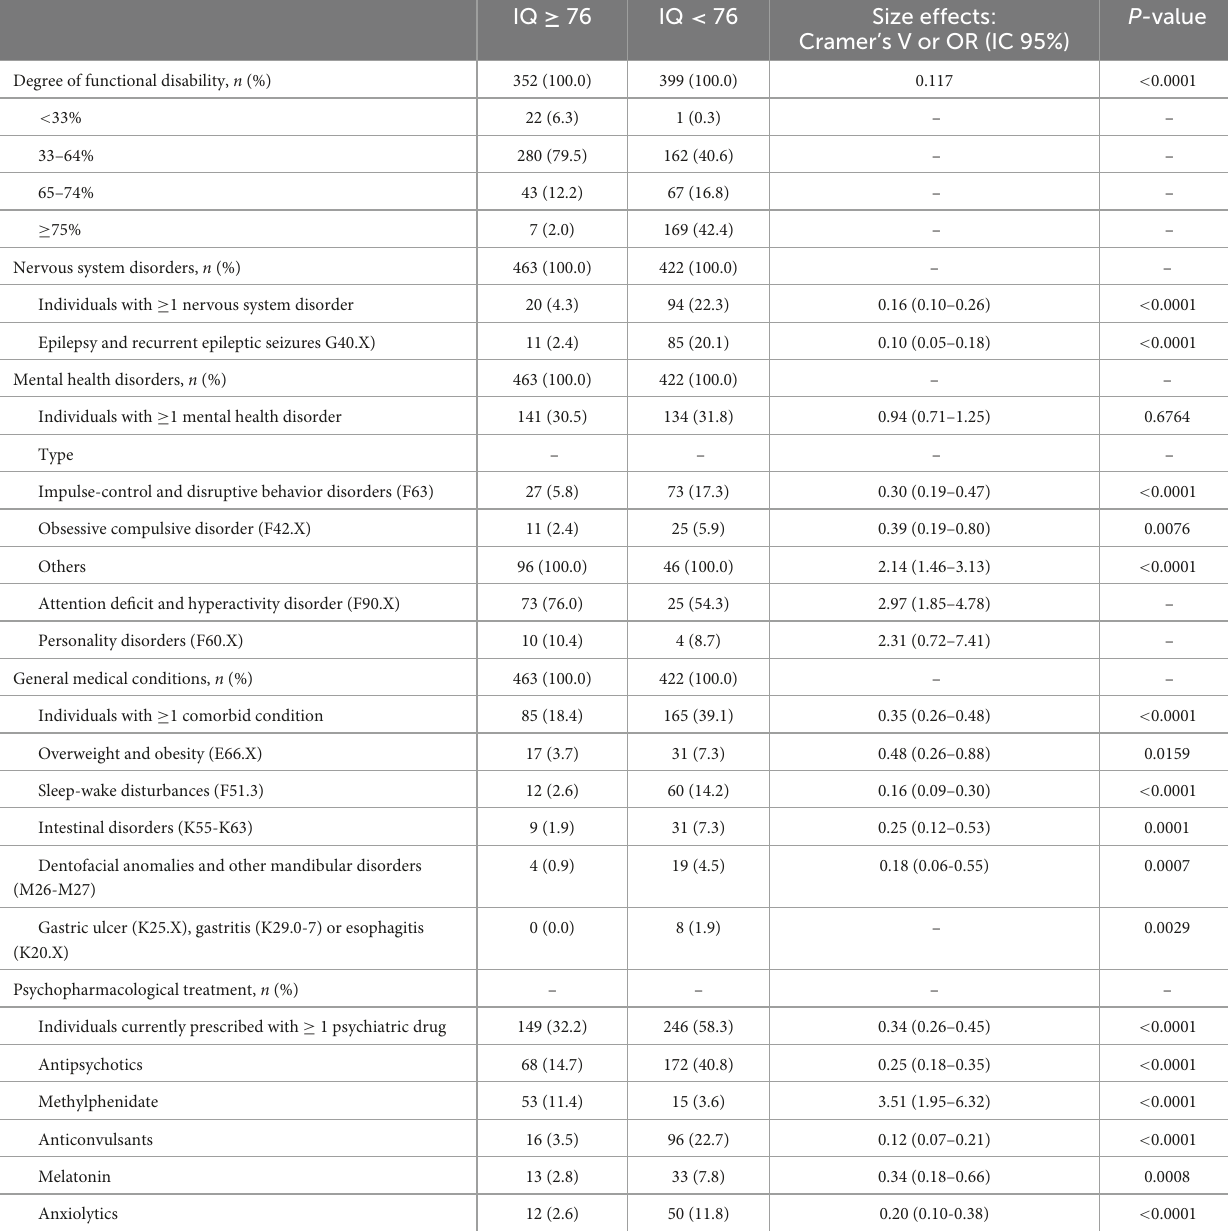
TABLE 5 Functional disability, nervous system, and mental health disorders, general medical conditions and psychopharmacological treatment according to intellectual quotient groups. IQ ≥ 76 IQ <